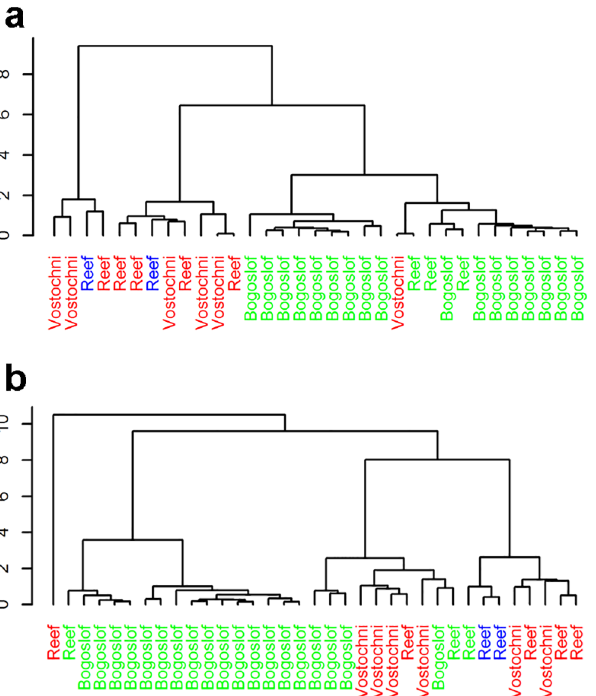
Fig 6. Dendograms from a hierarchical cluster analysis of 17 fatty acids from northern fur seal blubber (a) and milk (b) samples. Red, green, and blue labels indicate animals categorized as on-, off-, or mixed-shelf foragers,